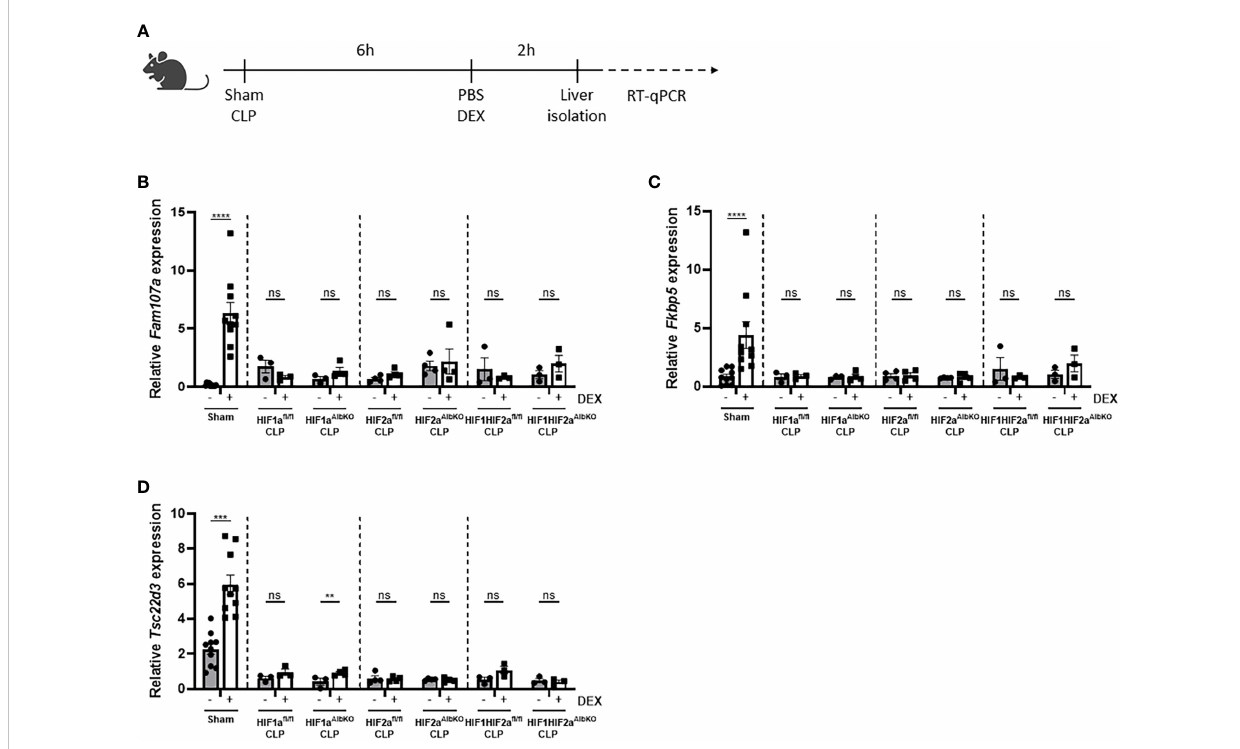
FIGURE 6 No role for HIF1 a and/or HIF2 a in hepatocytes in mediating GCR during sepsis. (A) HIF1a AlbKO , HIF2a AlbKO or HIF1aHIF2a AlbKO mice and wild-type littermates were randomly assigned to a sham or CLP procedure. 6h post-surgery, mice were injected i.p. with PBS or DEX (10 mg/kg) and the livers were isolated 2h later. The mRNA expression levels of Fam107a (B) , Fkbp5 (C) and Tsc22d3 (D) were measured via RT-qPCR. One experiment (n=3/ group). Data is pooled for the wild-type mice. All bars represent mean ± SEM. P-values were analyzed via two-way ANOVA. ****P < 0.0001, ***P < 0.001. ns, non-signi fi